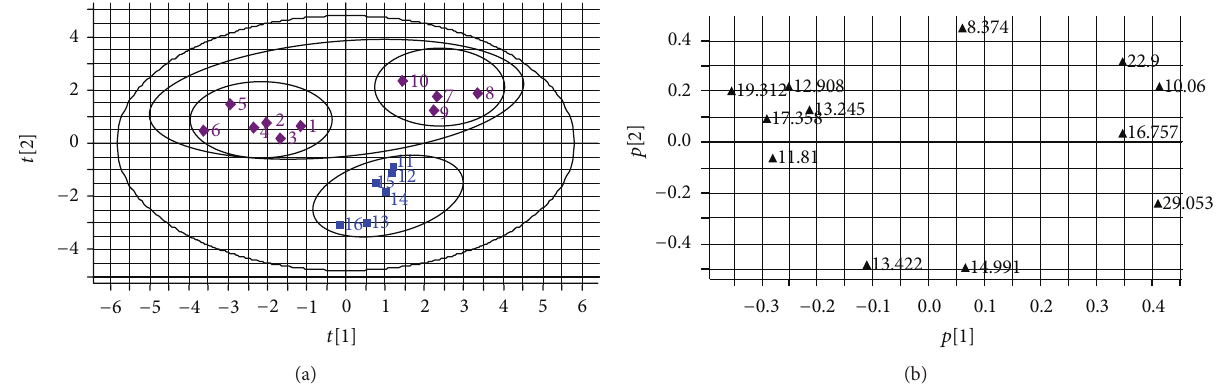
Figure 3: (a) Score plots from PCA; (b) loading plots from PCA, in which each variable represents the retention time (min) in chromatographic profiles.